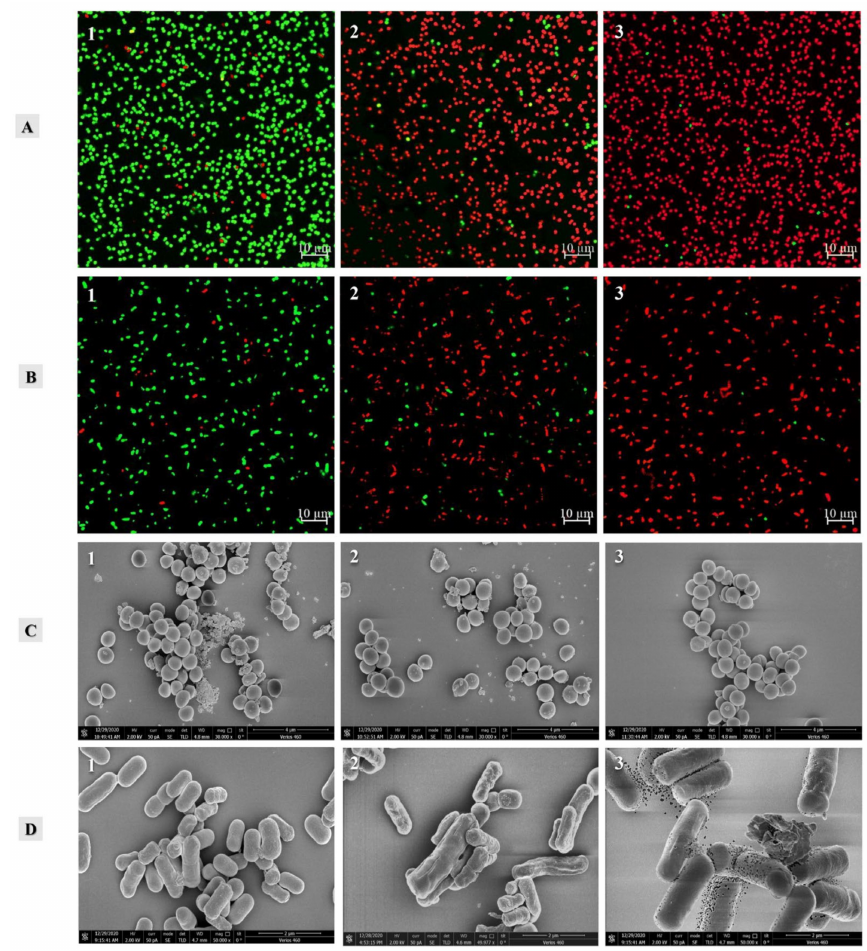
Figure 4. Effects of verbascoside on bacterial strains. ( A ) and ( B ) Cell membrane integrity of MDR S. aureus SA-596 and MDR P. aeruginosa PA-69. ( C ) and ( D ) Cell morphology of MDR S. aureus SA-596 and MDR P. aeruginosa PA-69. (1) Untreated bacterial strains. (2) Bacterial strains treated with verbascoside at the MIC. (3) Bacterial strains treated with verbascoside at 2 ×